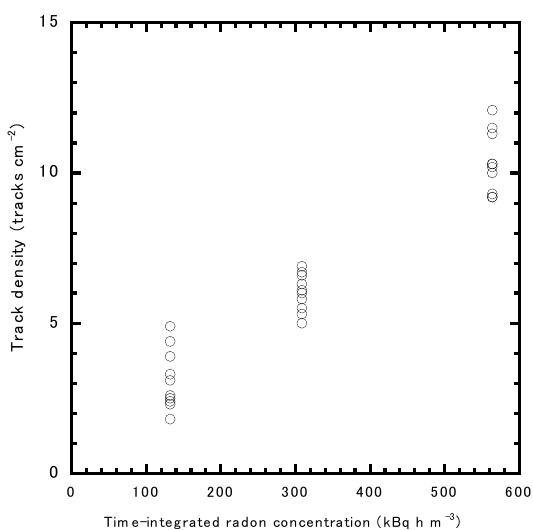
Figure 2. The relationship between the time-integrated radon concentration and alpha track density. Ten CR-39 pieces were exposed for each condition.